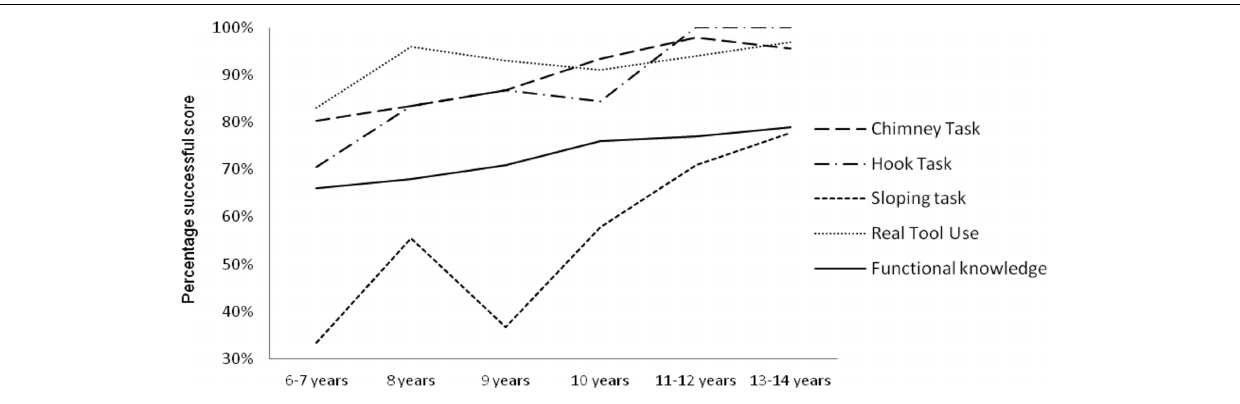
FIGURE 3 | Developmental course of MPS, RTU, and FK tests ( n = 85). Percentage successful score accuracy-based scoring system for the three MPS tasks.